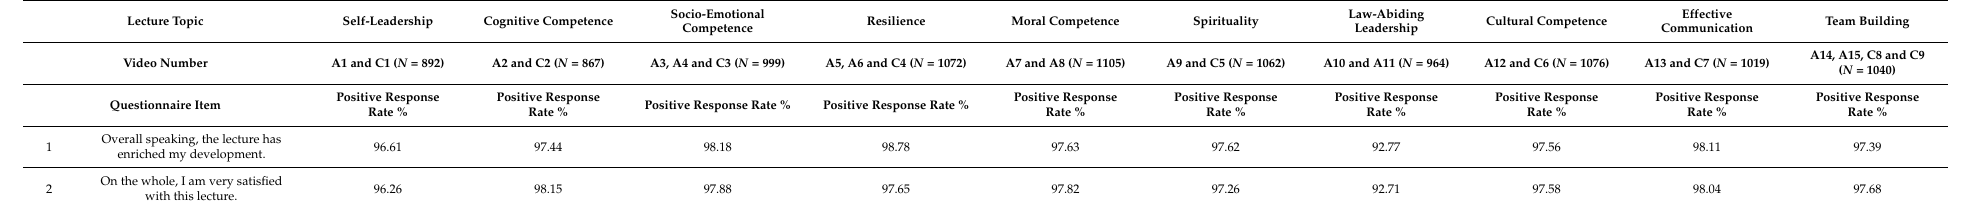
Table 7. Positive Responses Rates of Post-Lecture Video Evaluation for Lectures 2 to 11 (Two Items Evaluating the Effectiveness of the